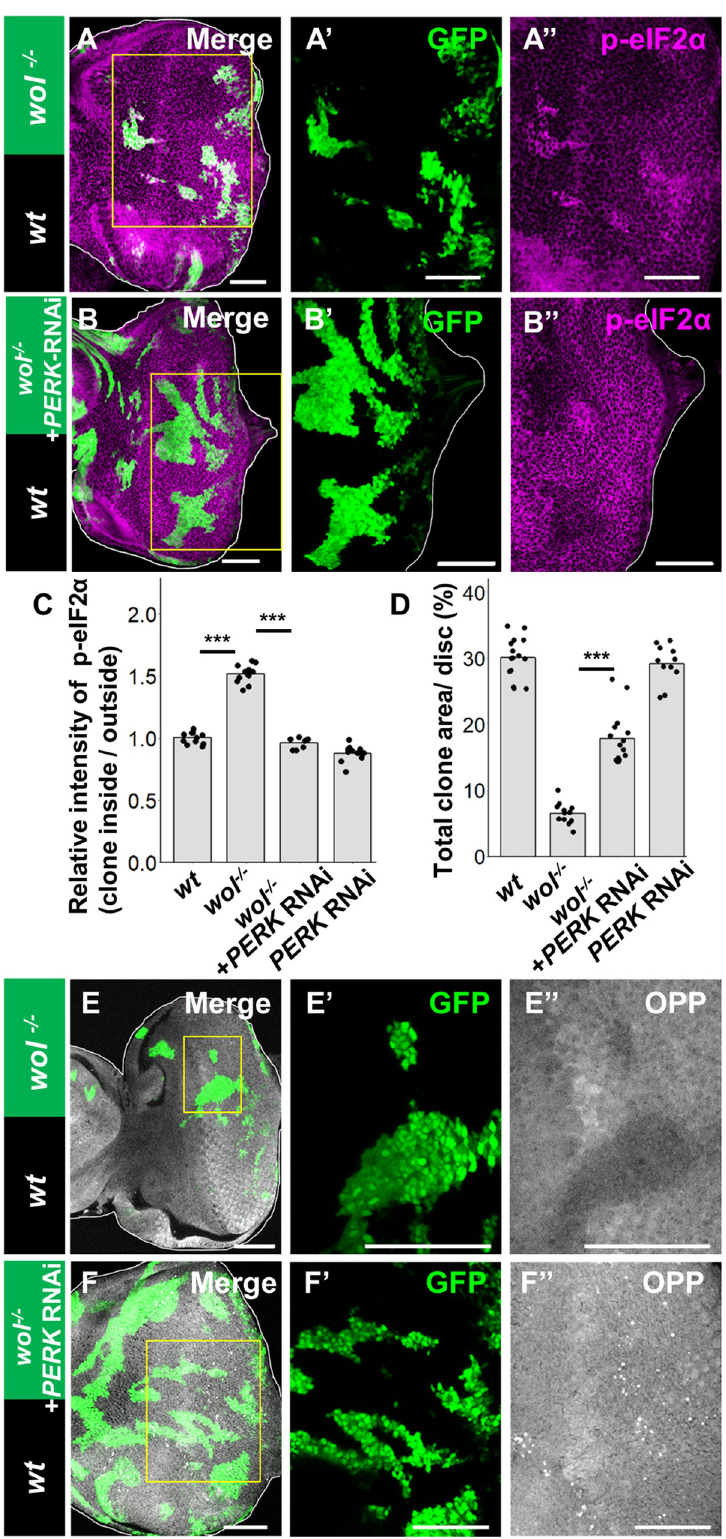
Fig 2. Cell competition is driven by phosphorylation of eIF2 α . (A and B) Eye disc bearing eyFLP-induced MARCM clones of wol ccp-28-/- (A) or wol ccp-28-/- + PERK-RNAi (B) cells stained with anti-phosphorylated eIF2 α .